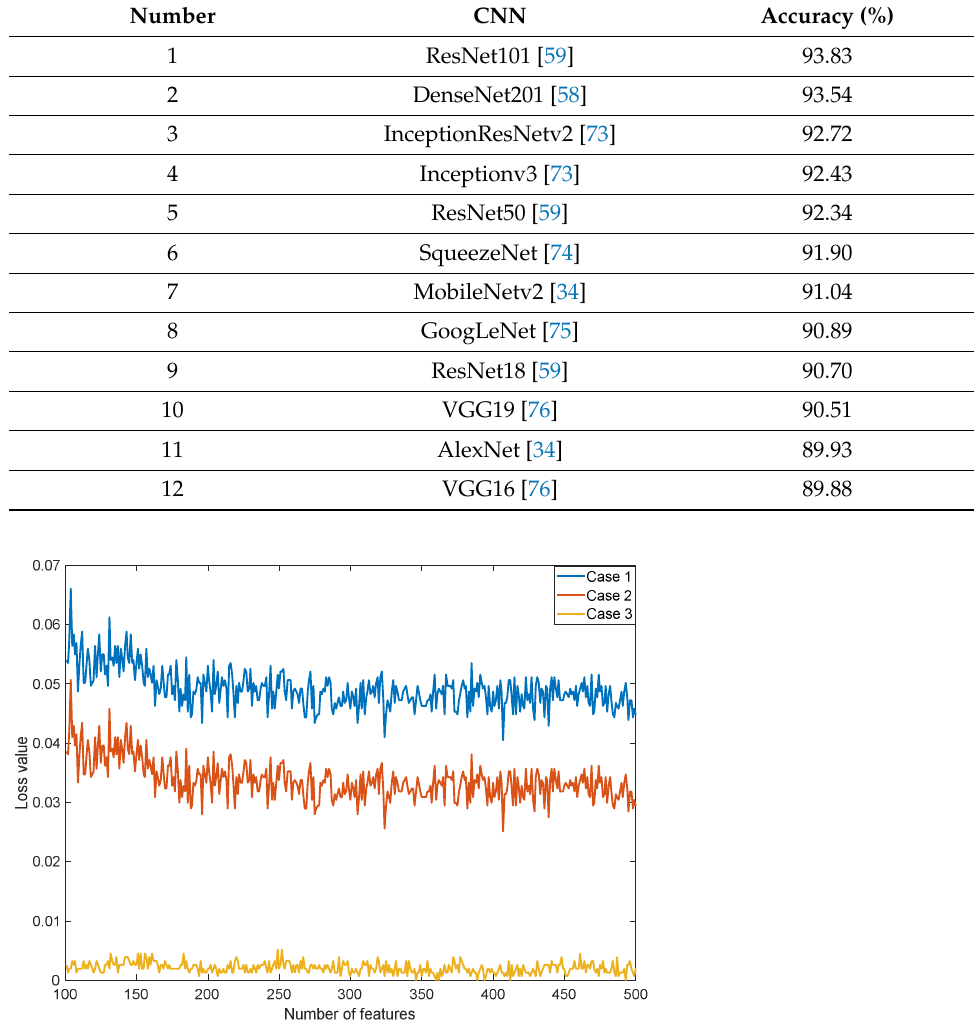
Figure 8. Graph of loss value versus number of features using TRFIRF selector for Case 1, Case 2, and Case 3.